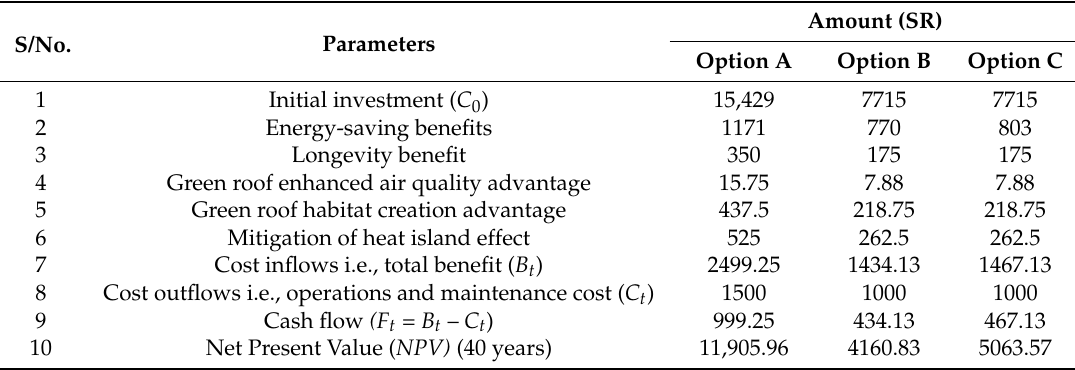
Table 5. Computation of NPV for various green roof types (Saudi Riyals SR).